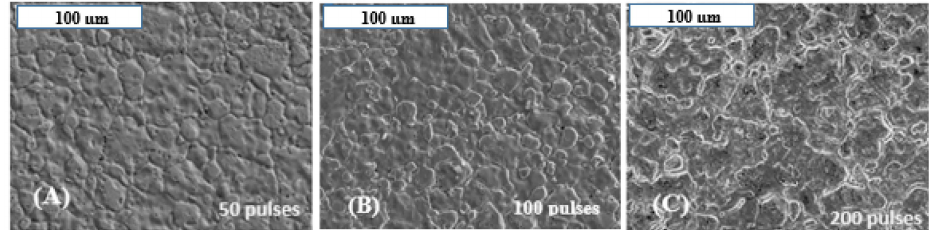
Figure 4. The microstructure of Nimonic 263 after LSP by laser pulse energy of 10 mJ ( F = 0.2 J ¨ cm ´ 2 ), wavelength of 1064 nm, and number of pulses 50 ( A ); 100 ( B ) and 200 ( C ), respectively (power density 3.3 GW/cm 2